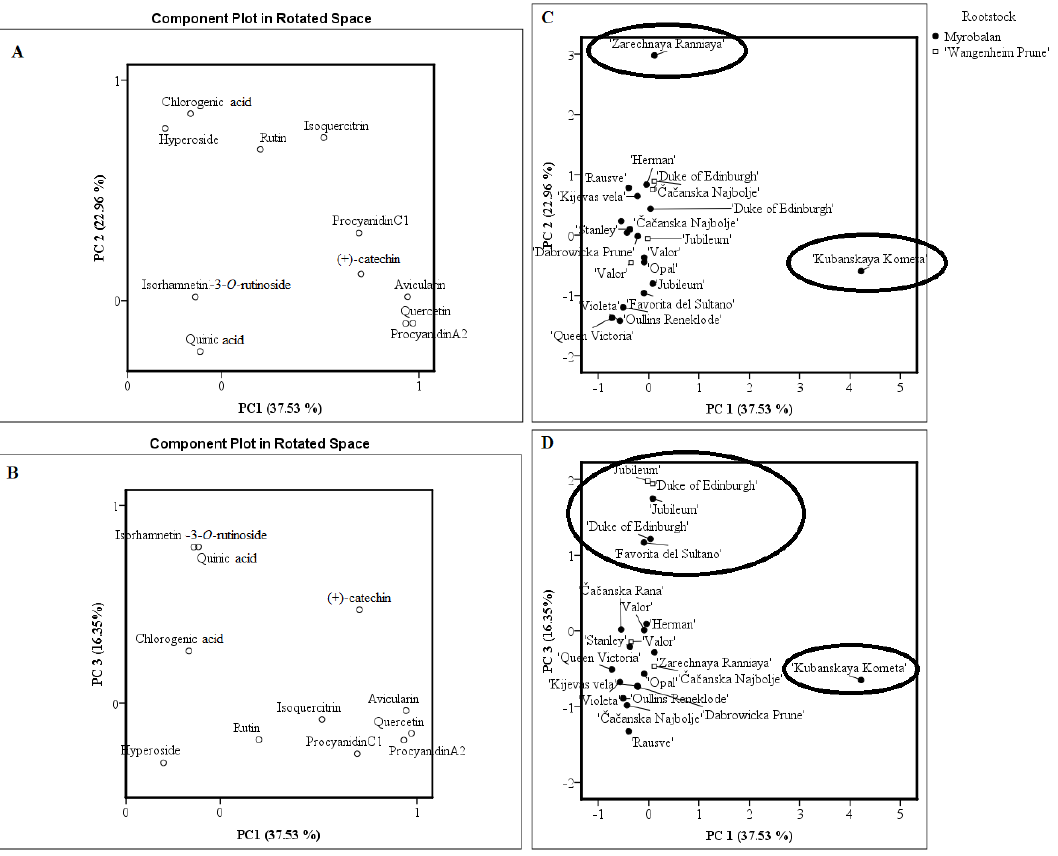
Figure 2. PCA loading ( A , B ) and score ( C , D ) plots of plum fruit samples of different